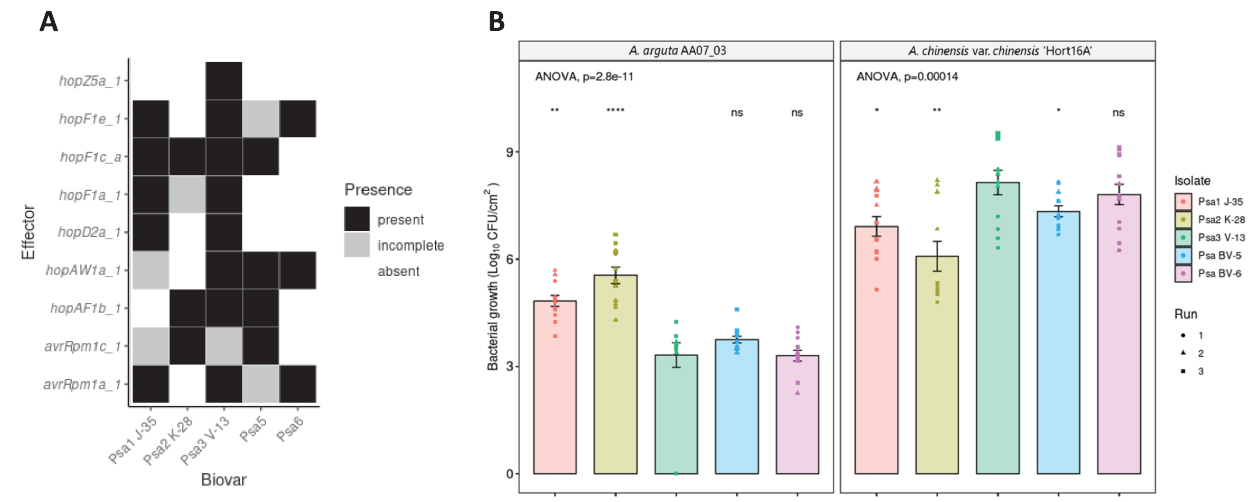
Fig 7. Pathogenicity assay of Pseudomonas syringae pv. actinidiae (Psa) biovars in Actinidia arguta indicates broad recognition across biovars. (A) Effectors of interest across strains representative of the Psa biovars. Selected effector repertoires collated from McCann et al. [15] and Sawada et al. [69]. Black indicates when an effector is present; grey indicates when an effector is either truncated, disrupted or incomplete; and white indicates when an effector is absent from a given strain. (B) A . arguta AA07_03 and A . chinensis var. chinensis ‘Hort16A’ kiwifruit plantlets were flood-inoculated at approximately 10 6 cfu/mL with Psa1 J-35, Psa2 K-28, Psa3 V-13, Psa5 MAFF212057, and Psa6 MAFF212134 strains. Bacterial growth was quantified at 12 days post-inoculation using plate count quantification. The experiment was conducted three times (biological replicates) with three batches of independently grown plants and data were stacked to generate the box plots and bar graphs shown. Asterisks indicate significant differences from ANOVA followed by a post hoc Student’s t -test between the indicated strain and wild-type Psa3 V-13, where p � .05 ( � ), p � .01 ( �� ), p � .001 ( ��� ), p � .0001 ( ���� ), and p > .05 (ns; not significant). Bar height represents the mean number of Log 10 cfu/cm 2 and error bars represents the standard error of the mean (SEM) between four pseudobiological replicates.